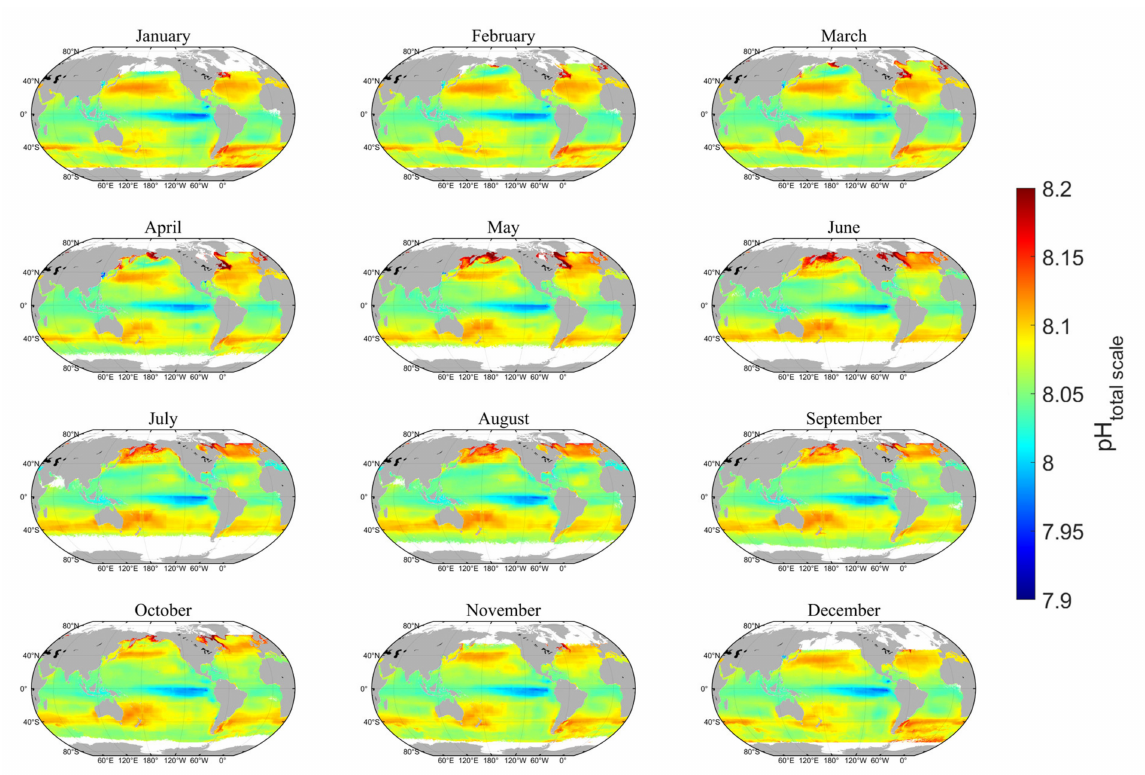
Figure 19. Climatological monthly averaged distribution of global sea surface satellite-derived